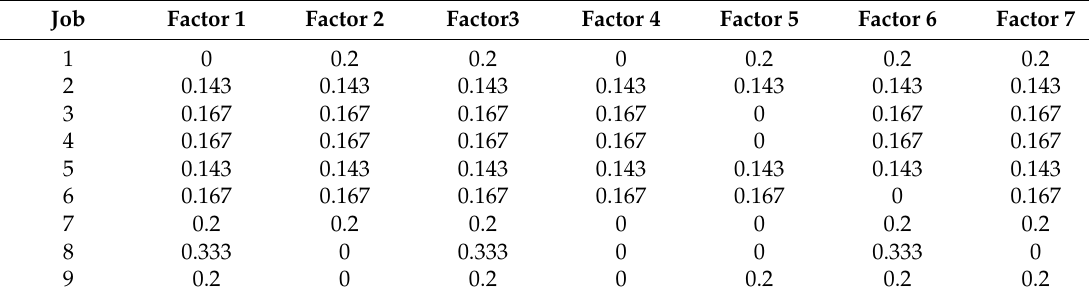
Table 9. Top 9 job complexity characteristic weights.